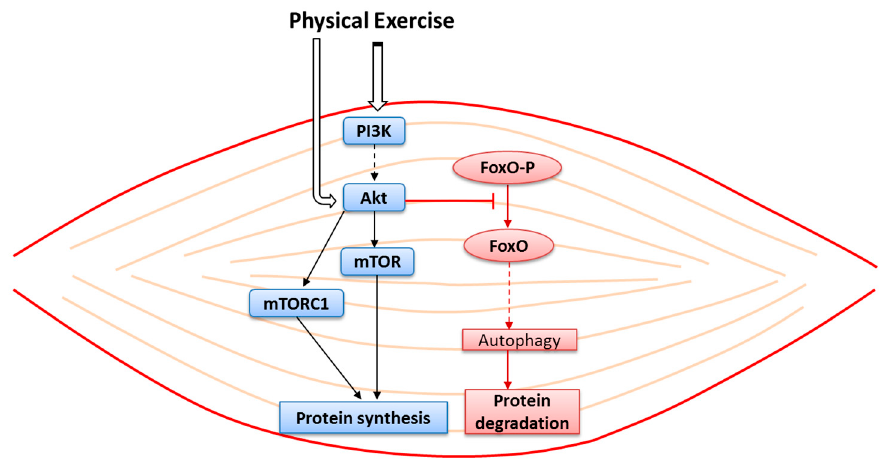
Figure 2. A schema of the intracellular pathway activated by physical exercise in skeletal muscle cells, showing protein synthesis (blue) and protein degradation pathway (pink). The solid line represents direct reaction; the broken line represents the intermediate pathway and products of reaction.